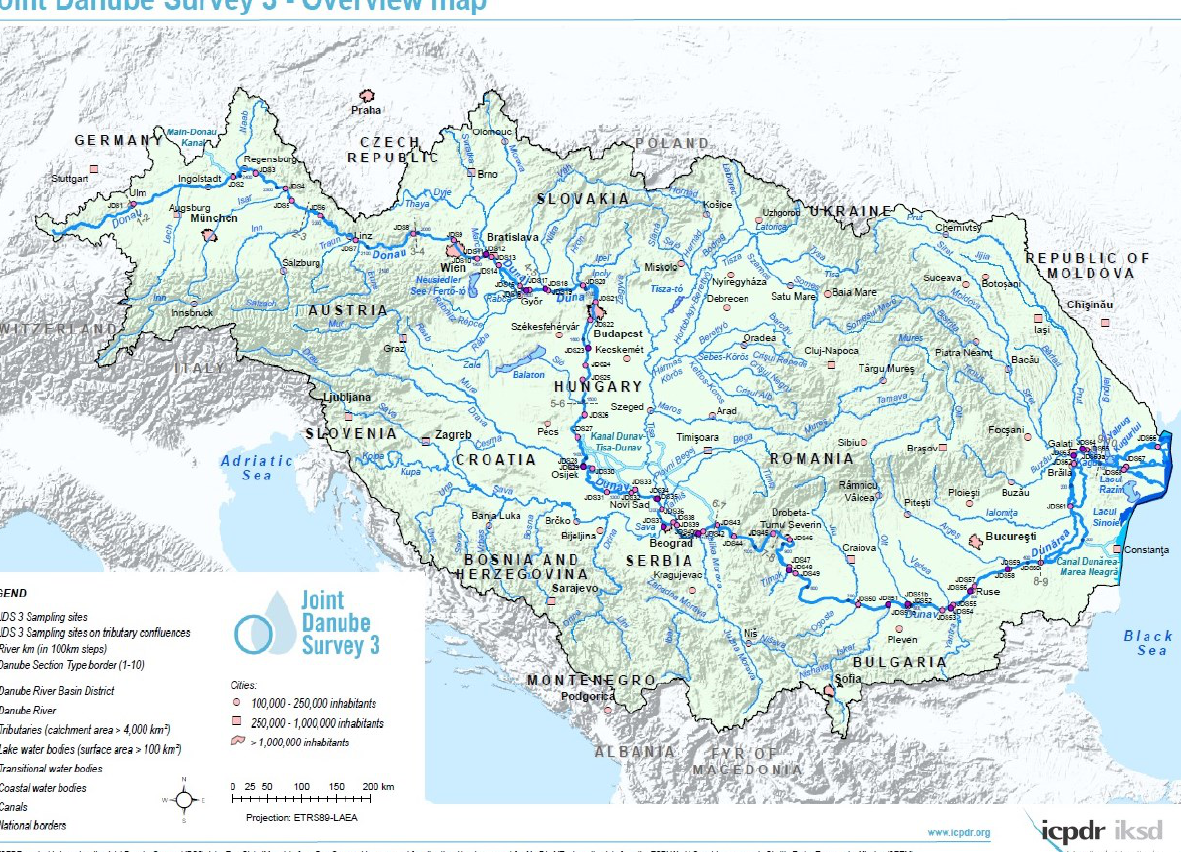
Figure 1. Overview of the Joint Danube Survey 3 (JDS3) sampling points along the river Danube. The map was taken with kind permission of the